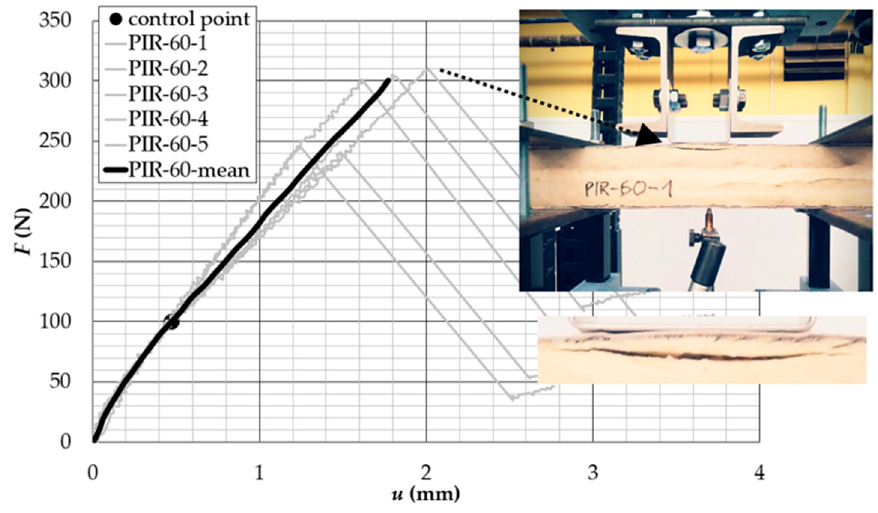
Figure 8. Load–displacement curves of the pull-out of a blind rivet from the sandwich beam facing.